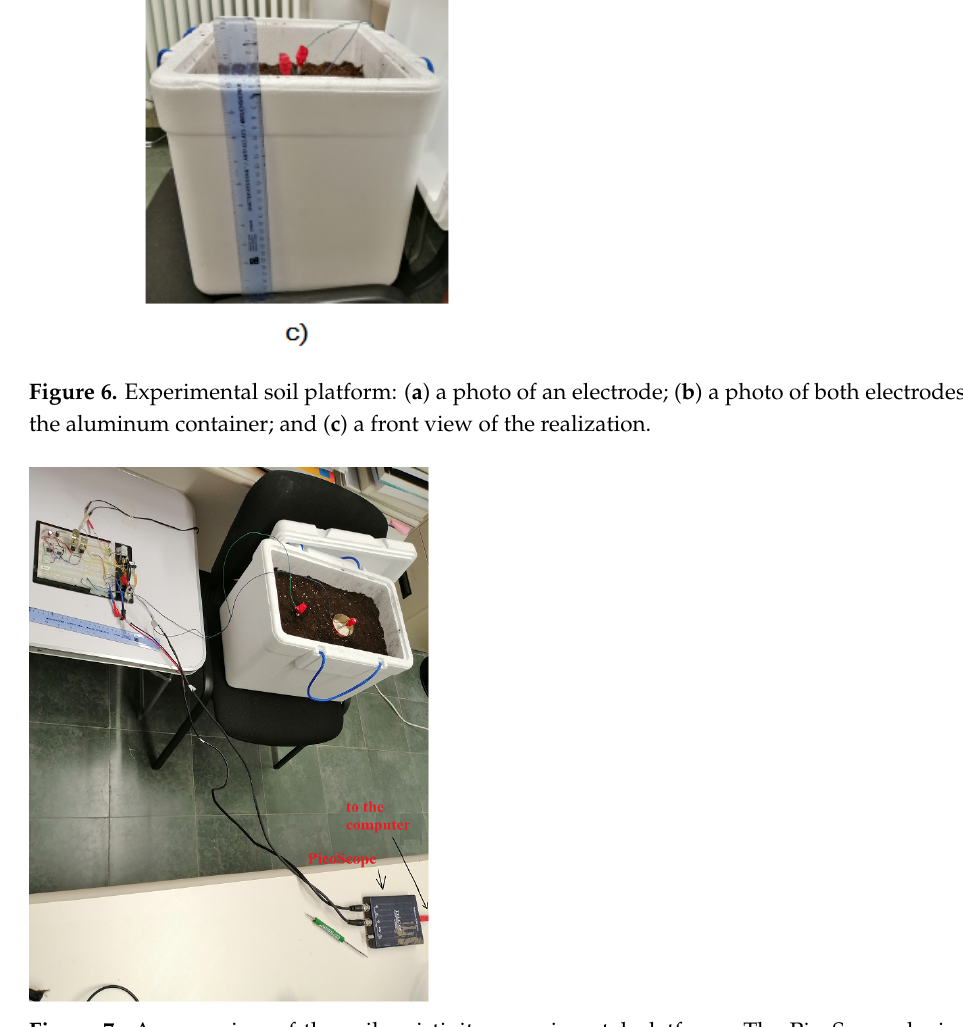
Figure 7. An overview of the soil resistivity experimental platform. The PicoScope device is a data-acquisition card, here employed to read the voltage values V A and V B via a